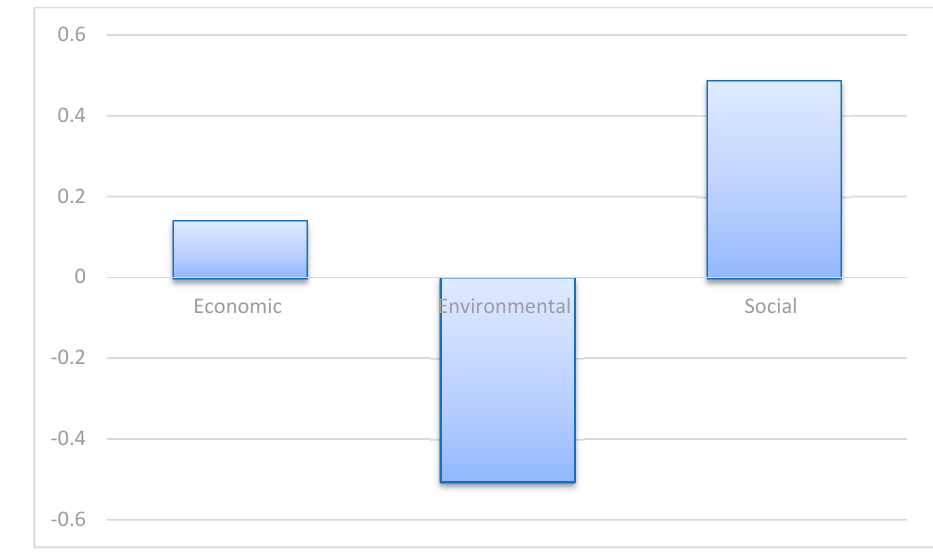
Figure 8. Average value for each factor (author).